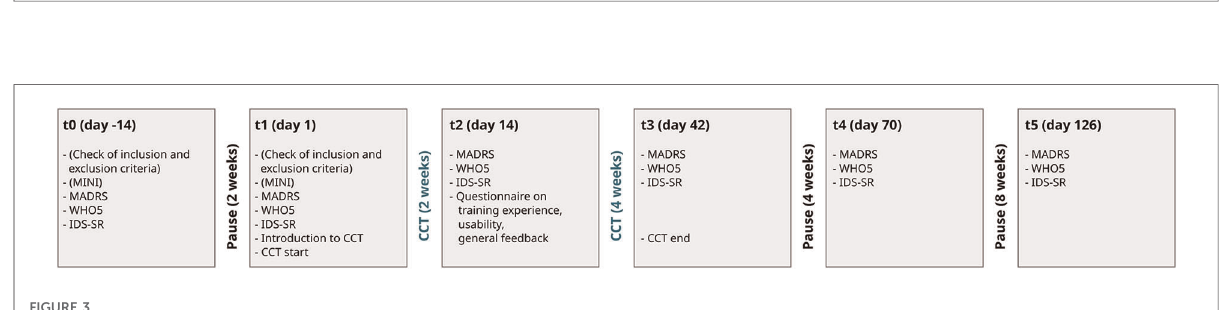
FIGURE 3 Study timeline showing the content of each